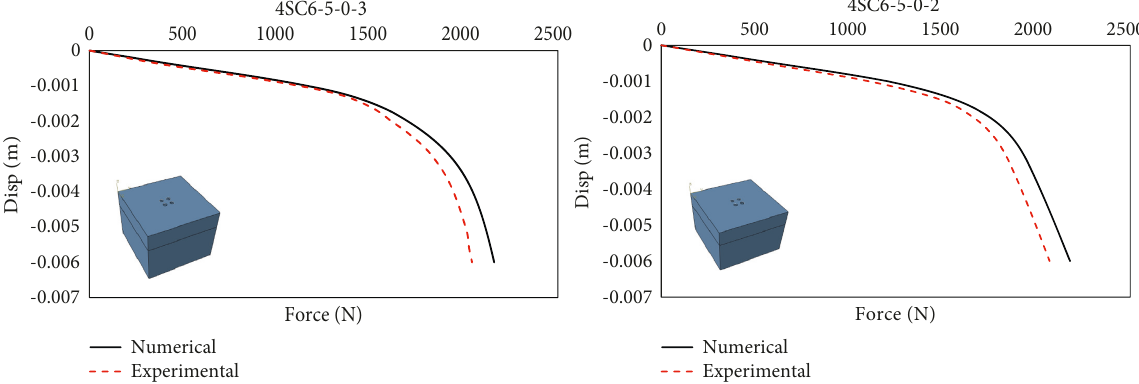
Figure 7: Conditional force-displacement diagram for 4SC6-5-0-2 and 4SC6-5-0-3 models in both numerical and laboratory